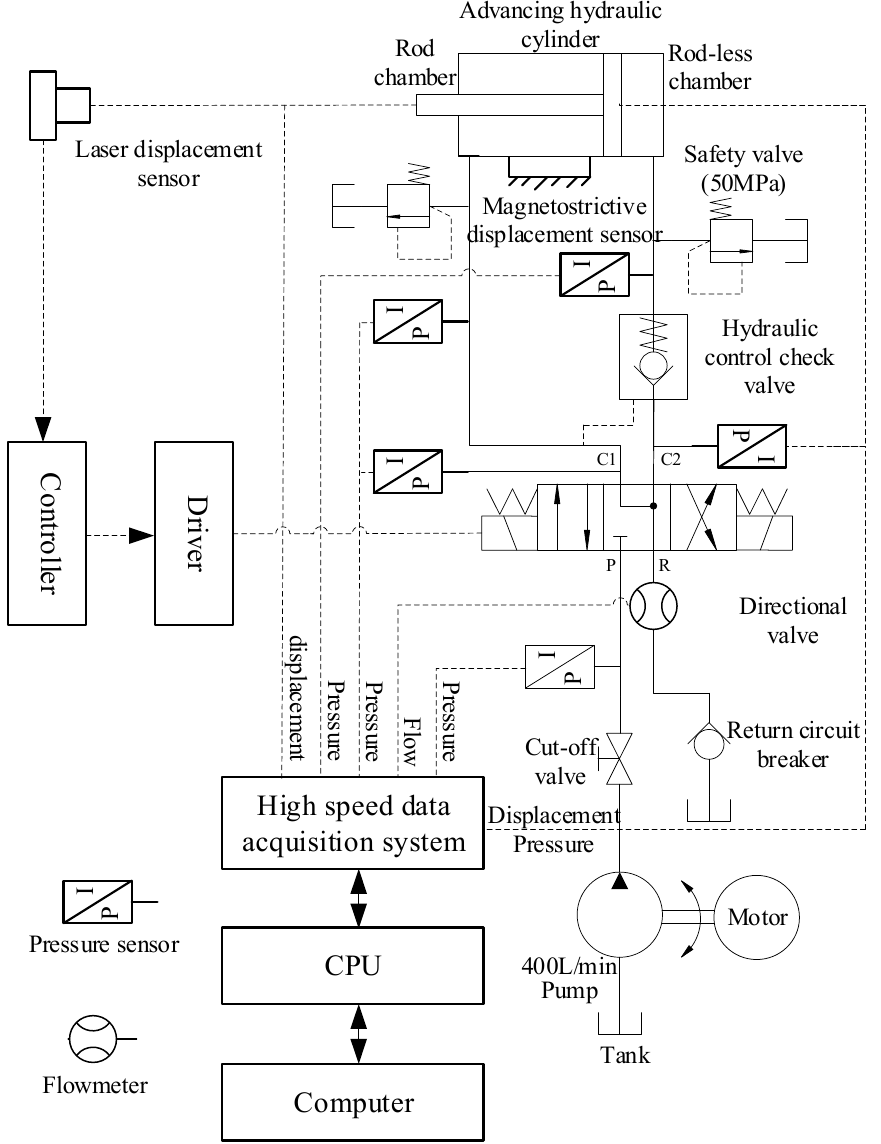
Figure 3. Hydraulic schematic diagram of the advancing test system. Then, 40 MPa pressure sensors are connected at the inlet of the directional valve, the outlet of the directional valve port C1, the outlet of the directional valve port C2, the rod chamber of the cylinder, and the rod-less chamber of the cylinder to detect the